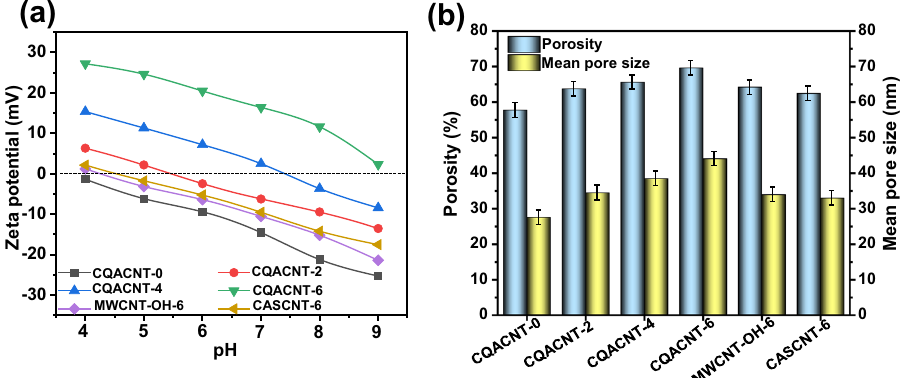
Fig. 7 Surface charge and pore characteristics of CQACNT, MWCNT-OH, and CASCNT composite membranes. a Zeta potential; b Porosity and mean pore size. Error bars represent the standard deviation between three reported values.